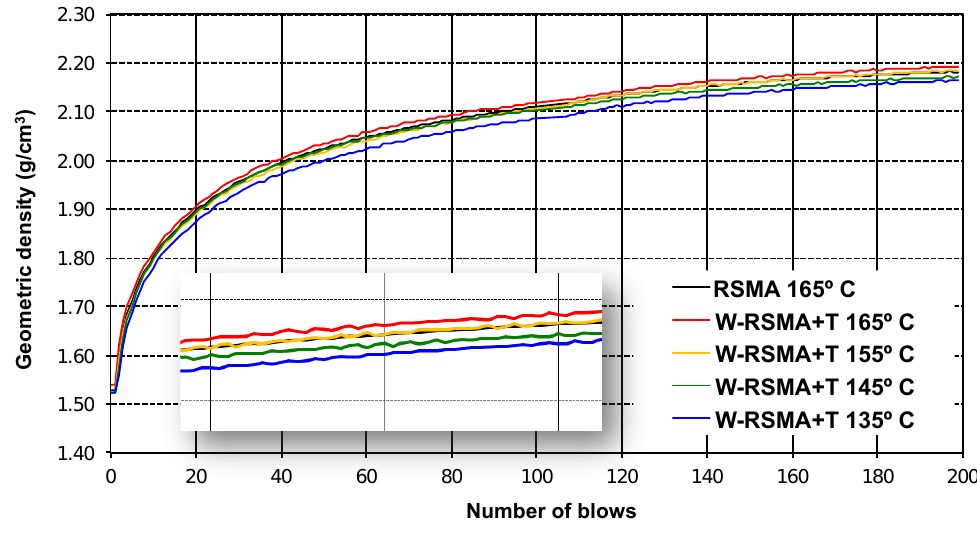
Figure 2. Compactability with Marshall compactor and Nosbur ® ThErmo+.